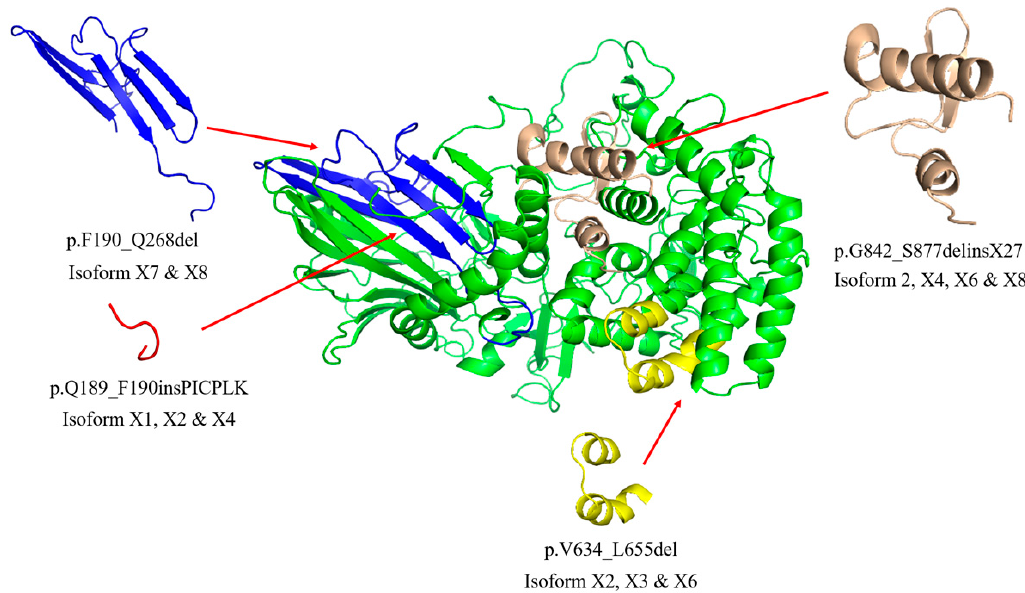
Figure 2. Structural model of human GBA2 highlighting the structures changed by deletions and insertions in the splicing isoforms relative to isoform 1. All structural variations are labeled relative to the human GBA2 isoform 1 reference sequence NCBI: NP_001317589.1. The homology models were generated based on the structure of TxGH116 (PDB: 5BVU) [30] with SWISS-MODEL [31]. The cartoon model of GBA2 isoform 1 (NCBI: NP_001317589.1) is shown in green with deletions shown in various colors with the deleted structures shown in the corresponding color to the side with the list of isoforms containing this variation. The insertion p.Q189_F190insPICPLK predicted structure (red) is positioned based on the isoform X1 model. Individual homology models are shown in SI Figure S1.